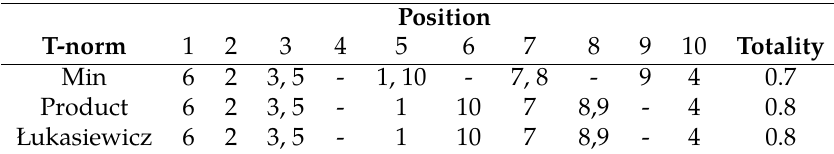
Table 7: Different orders for the requirement set used in the case study depending on the t-norm used in the prioritization process, considering the evaluated criteria to be equally